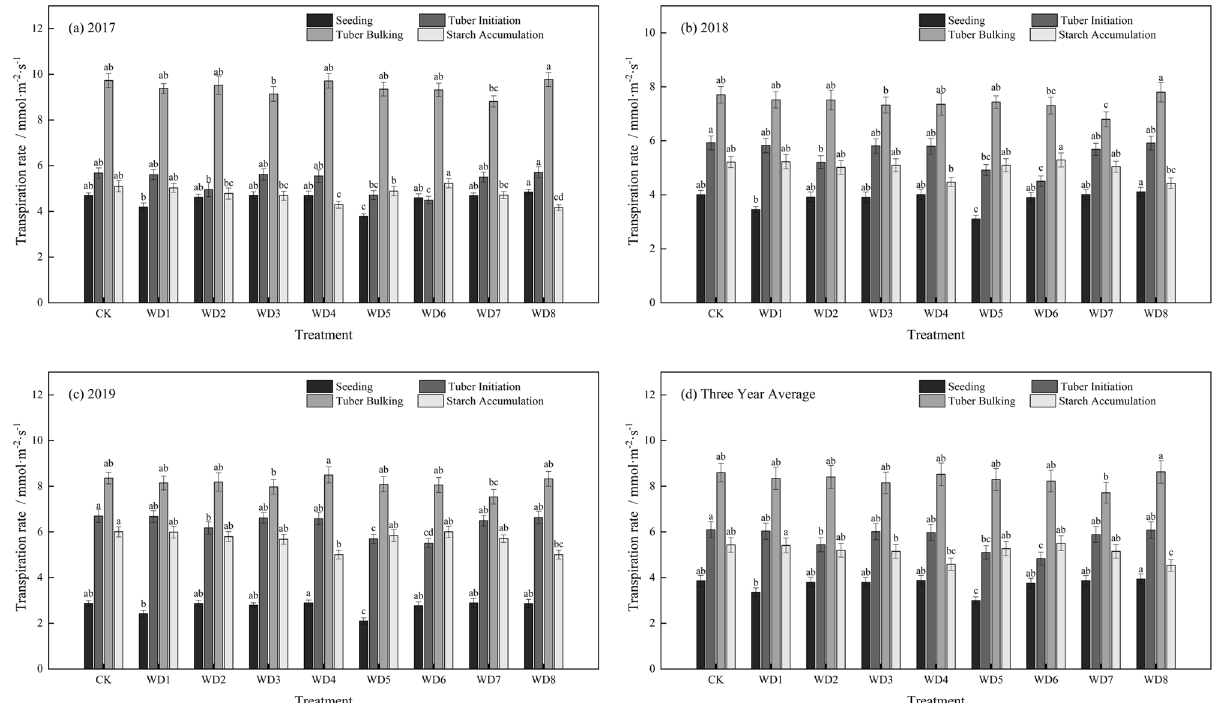
Figure 3. The effect of regulated deficit drip irrigation under film on the transpiration rate (mmol m −2 s −1 ) of potato leaf. The irrigation treatments were conventional irrigation (CK) and mild or moderate water deficit during each of four stages of potato growth. Mild deficit was in treatments WD1 (seedling), WD2 (tuber initiation), WD3 (tuber bulking), and WD4 (starch accumulation); moderate deficit was in treatments WD5 (seedling), WD6 (tuber initiation), WD7 (tuber bulking), and WD8 (starch